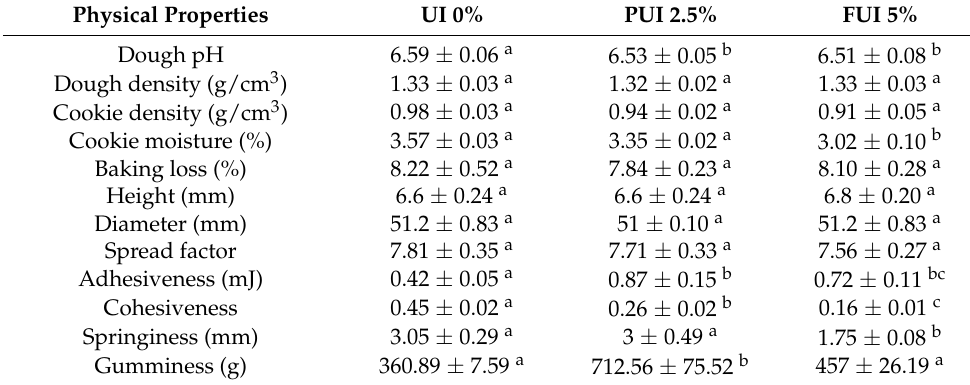
Table 2. Quality characteristics of value-added cookies with UI